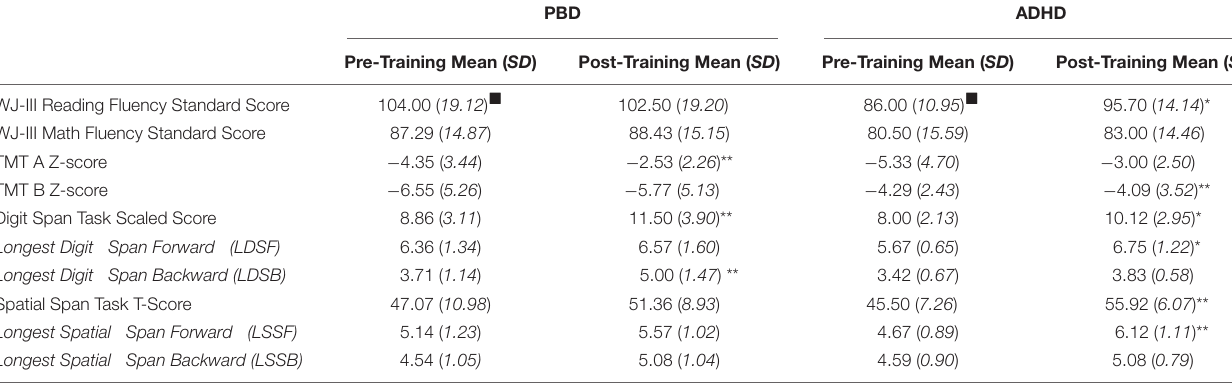
TABLE 2 | Pre- and post-training neuropsychological test scores for patients with PBD and patients with ADHD.